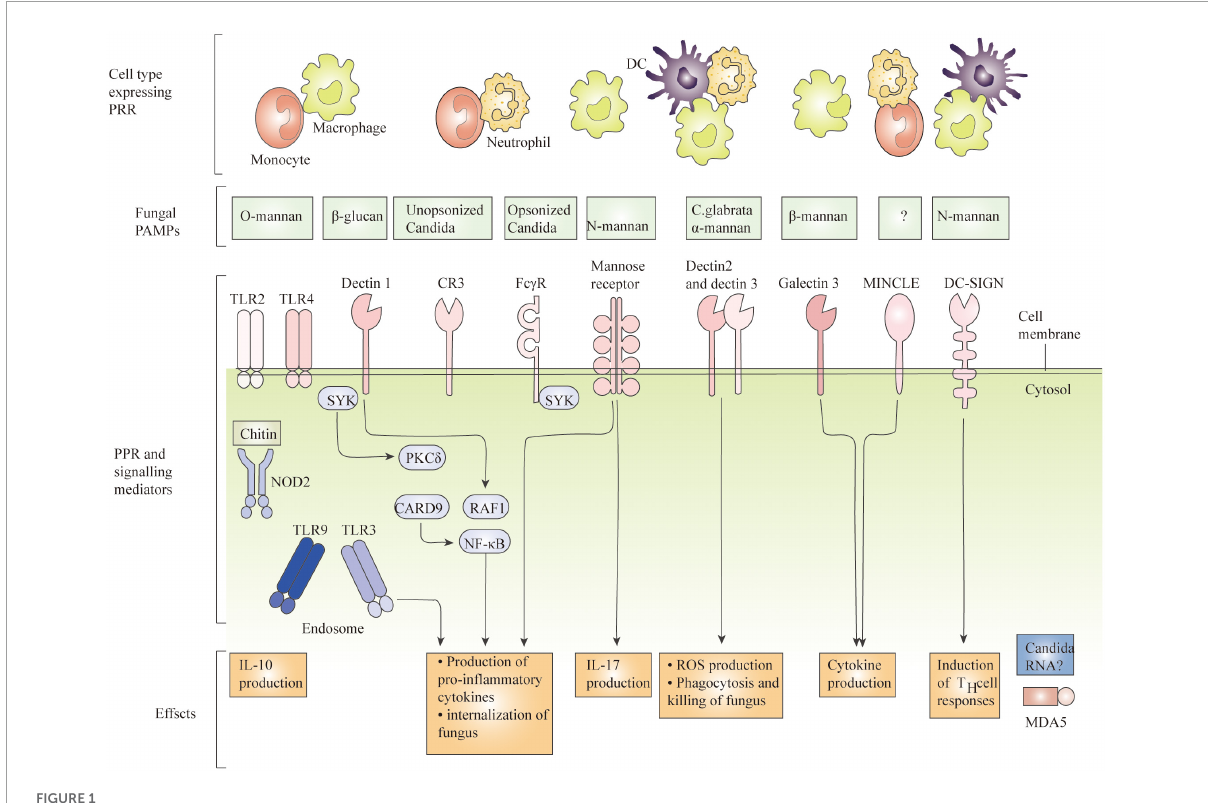
FIGURE1 Recognition of C. albicans by immune